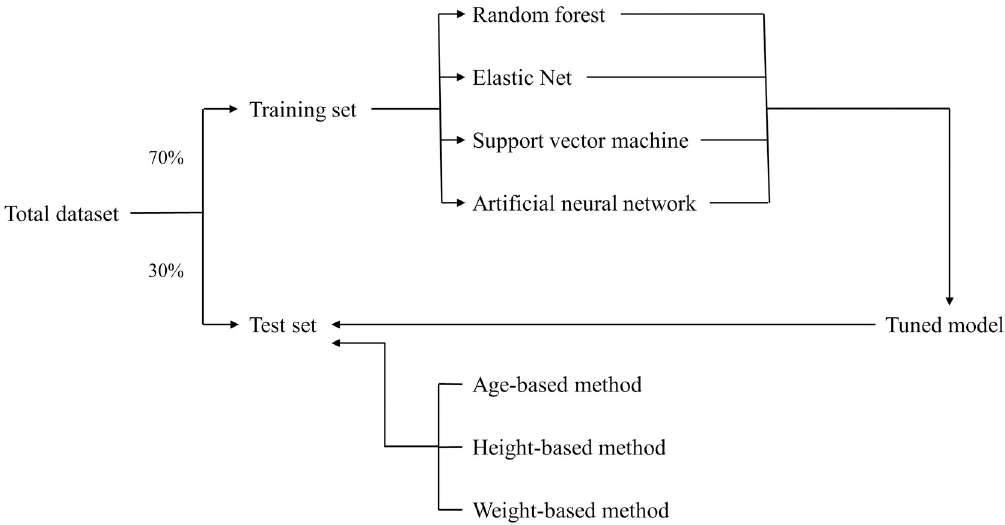
Fig 2. Flow diagram of application the machine learning and formula-based